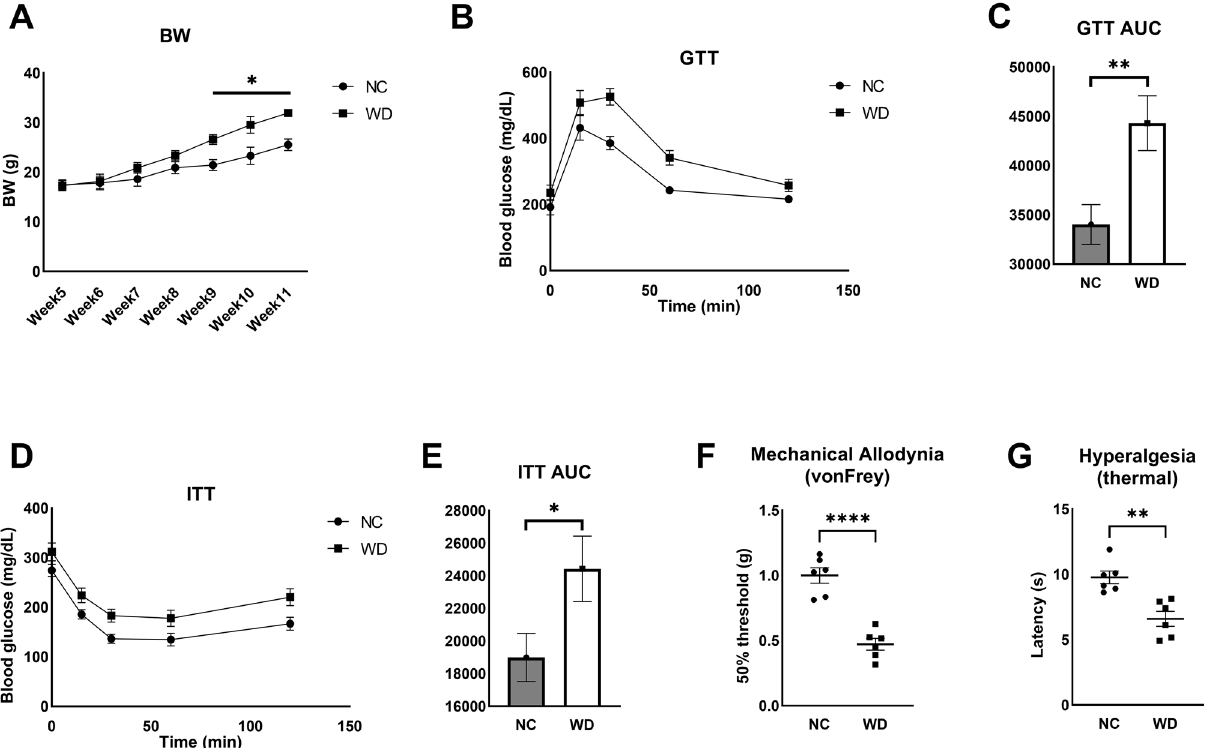
Figure 1. WD-fed mice develop glucose intolerance, insulin resistance and neuropathic pain. ( A ) Body weights (BW) taken over a period of 11 weeks of NC and WD-fed mice. ( B ) Glucose tolerance test and area under the curve ( C ). ( D ) Insulin tolerance test and area under the curve ( E ). ( F ) Von Frey behavioral test for mechanical allodynia. ( G ) Thermal behavioral test for hyperalgesia. Two-sample t-test, * p < 0.05, ** p < 0.005, **** p <